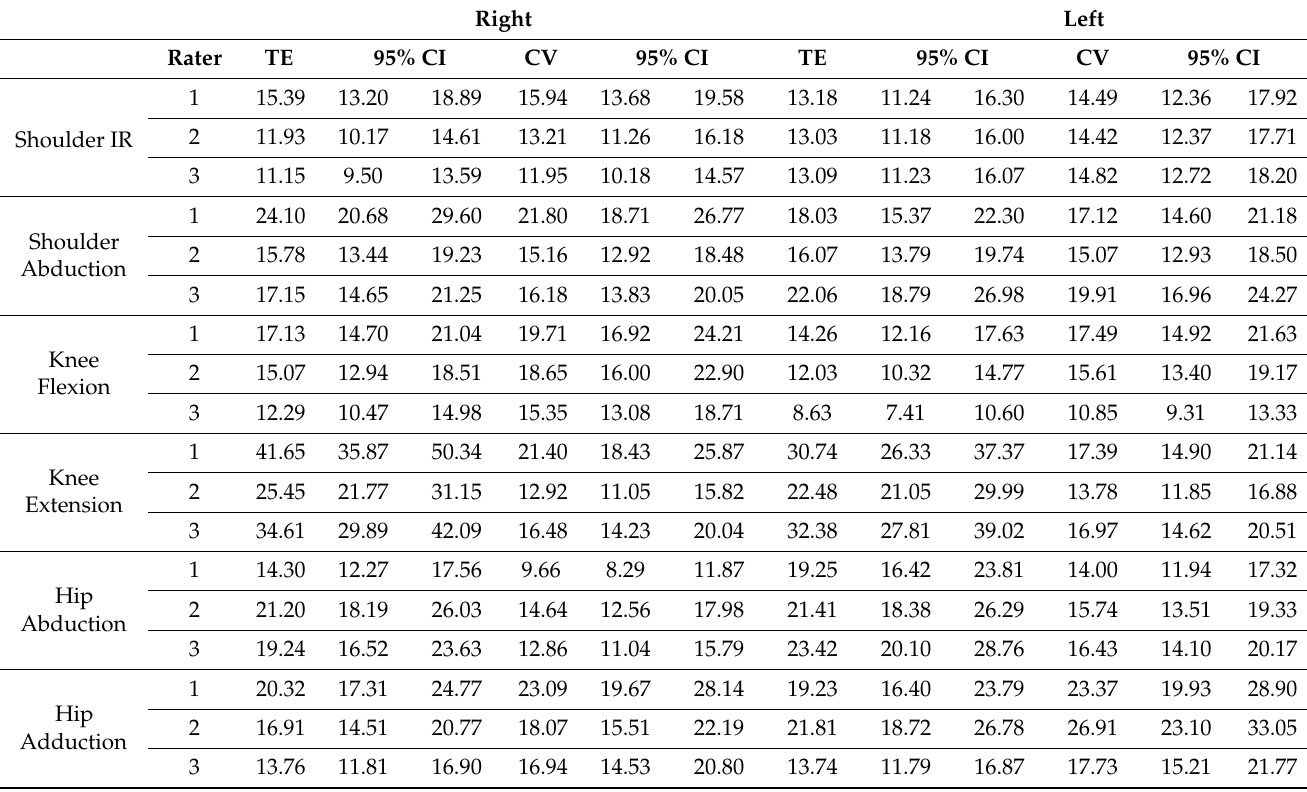
Table 3. Absolute intrarater reliability for shoulder, knee, and hip isometric strength.